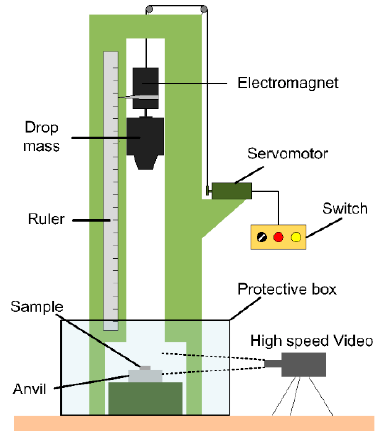
Figure 2. Schematic of the drop weight test apparatus.